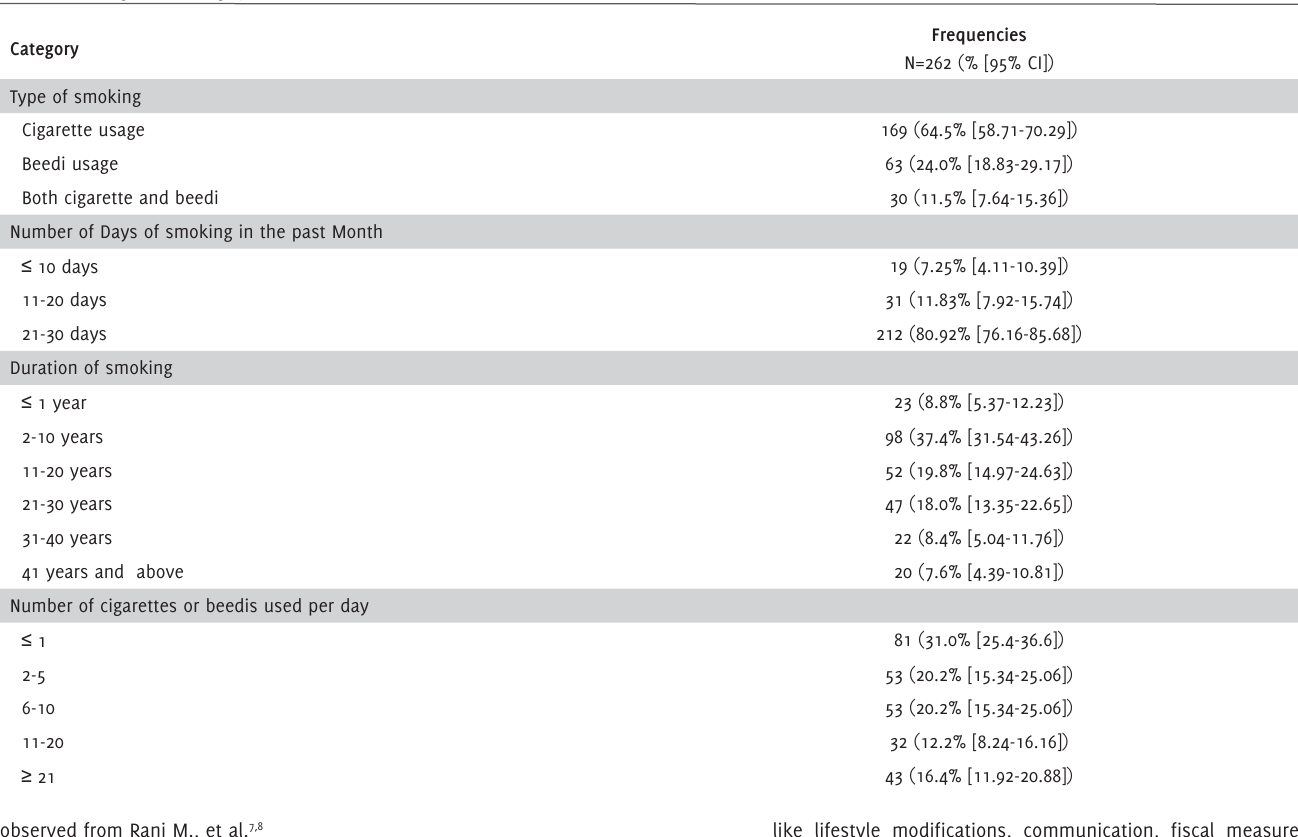
Table 2: Smoking tobacco usage pattern (n-262)